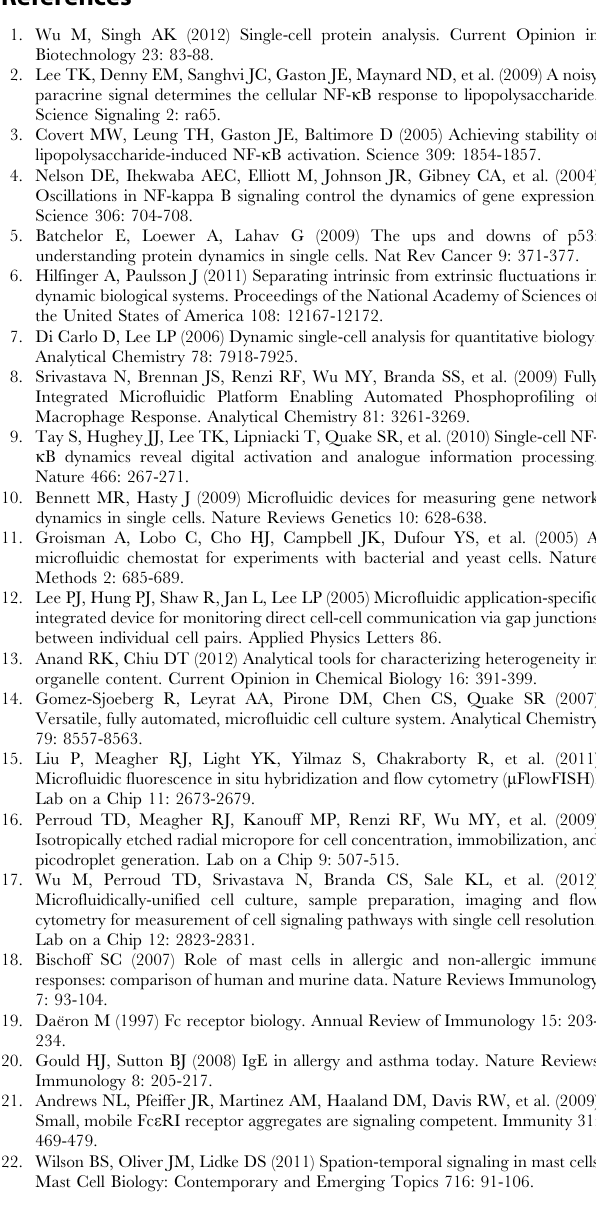
Figure S1 Comparison of stochastic and deterministic simulations results for Syk phosphorylation. The black and red lines represent time-dependent phosphorylation of Syk obtained by simulating the model deterministically and stochas- tically, respectively. Simulations are based on nominal parameters (Table 1); total protein copy numbers are set at their nominal mean values (Table 1). The phosphorylation curves in both cases correspond to stimulation with a ligand concentration of 10